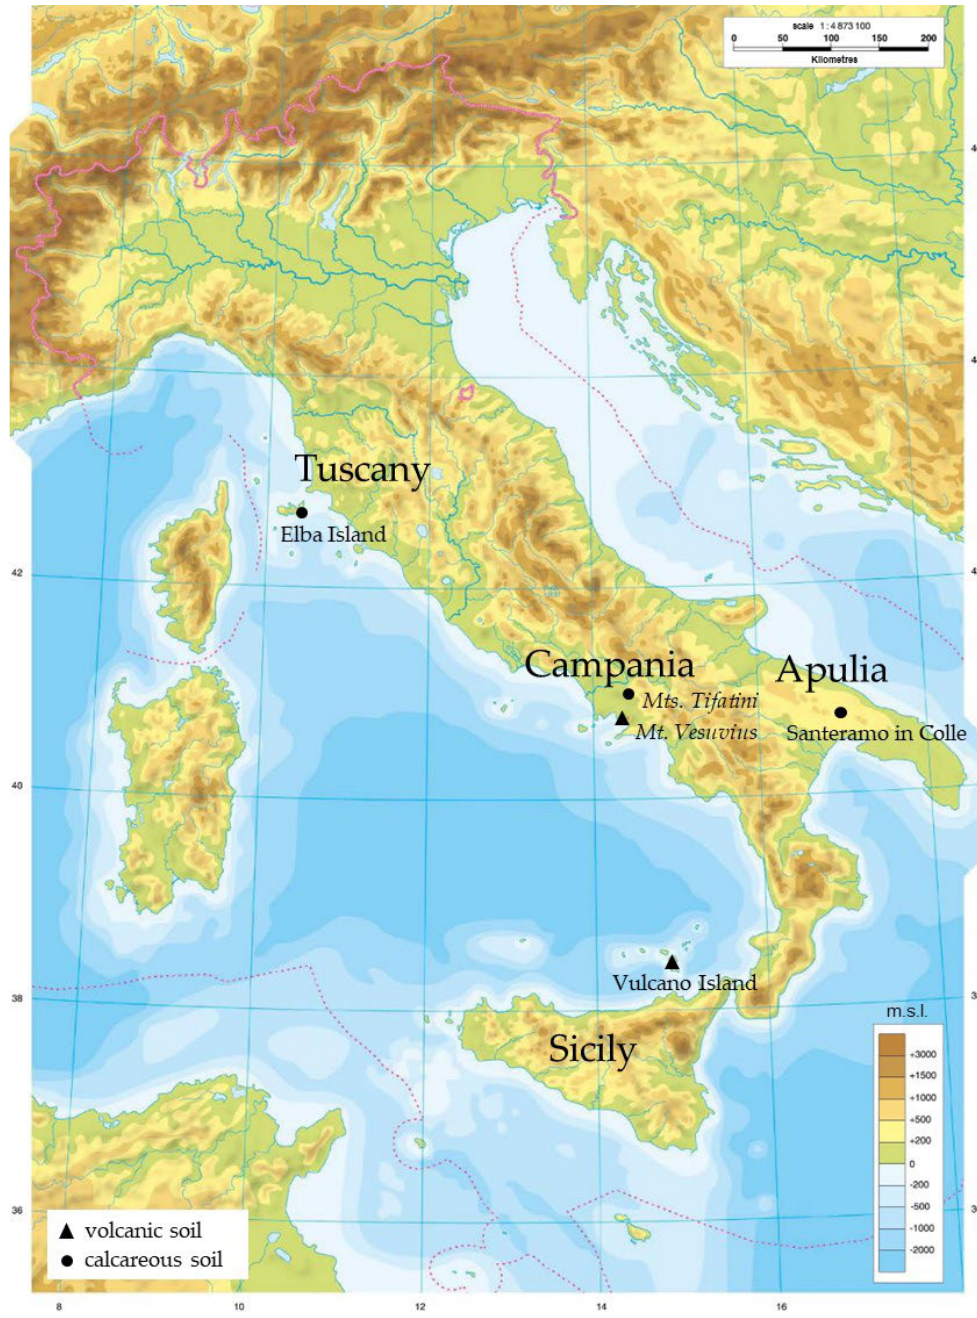
Figure 2. The sampling sites evaluated for the phytosociological classification.